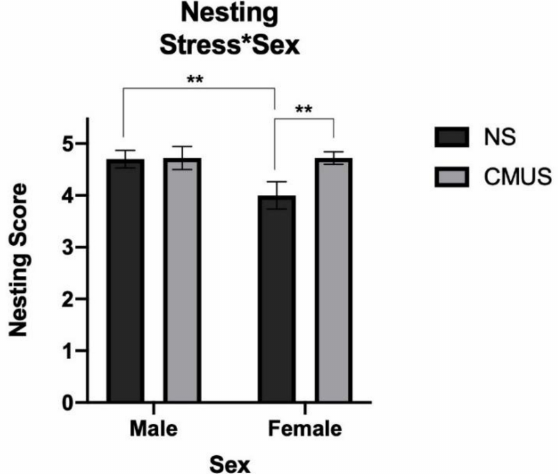
Figure 12. Nesting scores (stress*sex). Female mice undergoing CMUS made significantly better nests than females in the NS condition. Male mice under NS made significantly better nests than females in the NS condition (** p < 0.01).